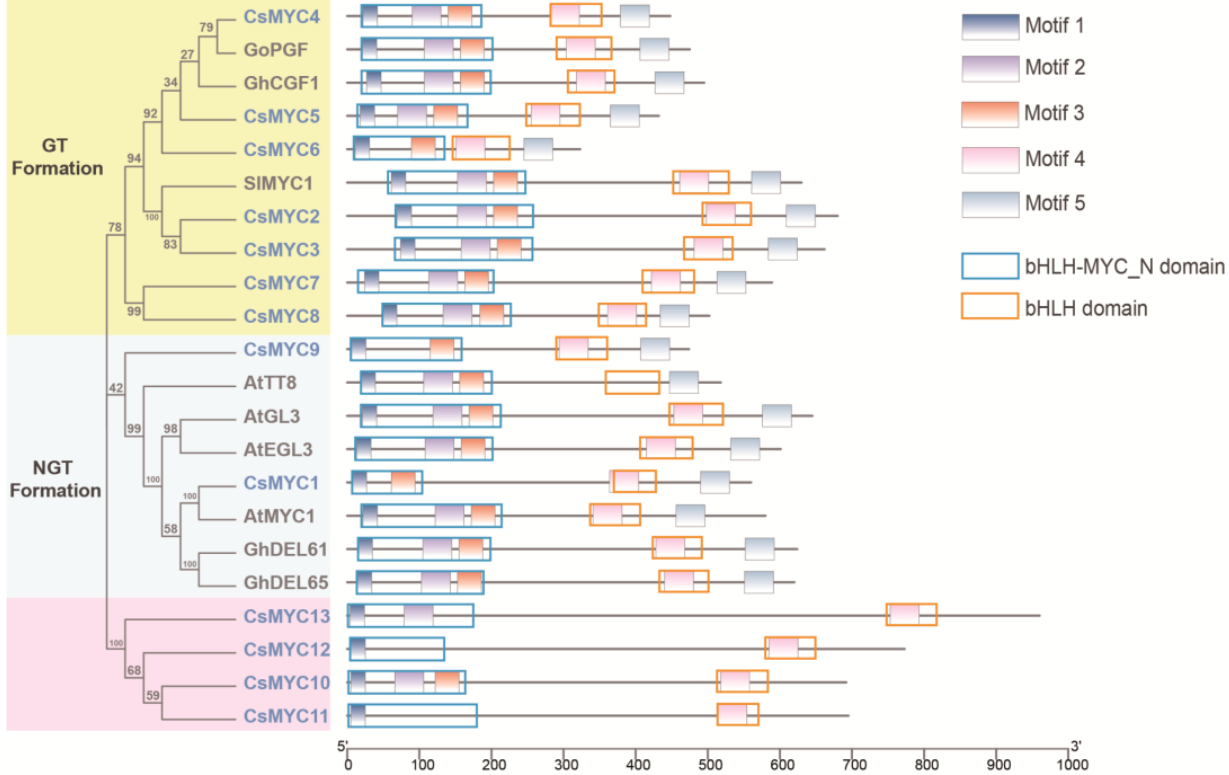
Figure 1. Phylogenetic analysis and conserved motifs analysis of cucumber MYC genes with previous reported-MYCs. Left panel: Molecular phylogenetic analysis of cucumber MYC genes and previous reported-MYCs by maximum likelihood method. Blue text represents CsMYCs. Middle panel: the conserved motifs of MYCs are represented by different colored boxes, the conserved domains of MYCs are represented by different colored rectangle. Cs, Cucumis Sativus ; Go/Gh, Gossypium hirsutum ; Sl, Solanum lycopersicum ; At, Arabidopsis thaliana .